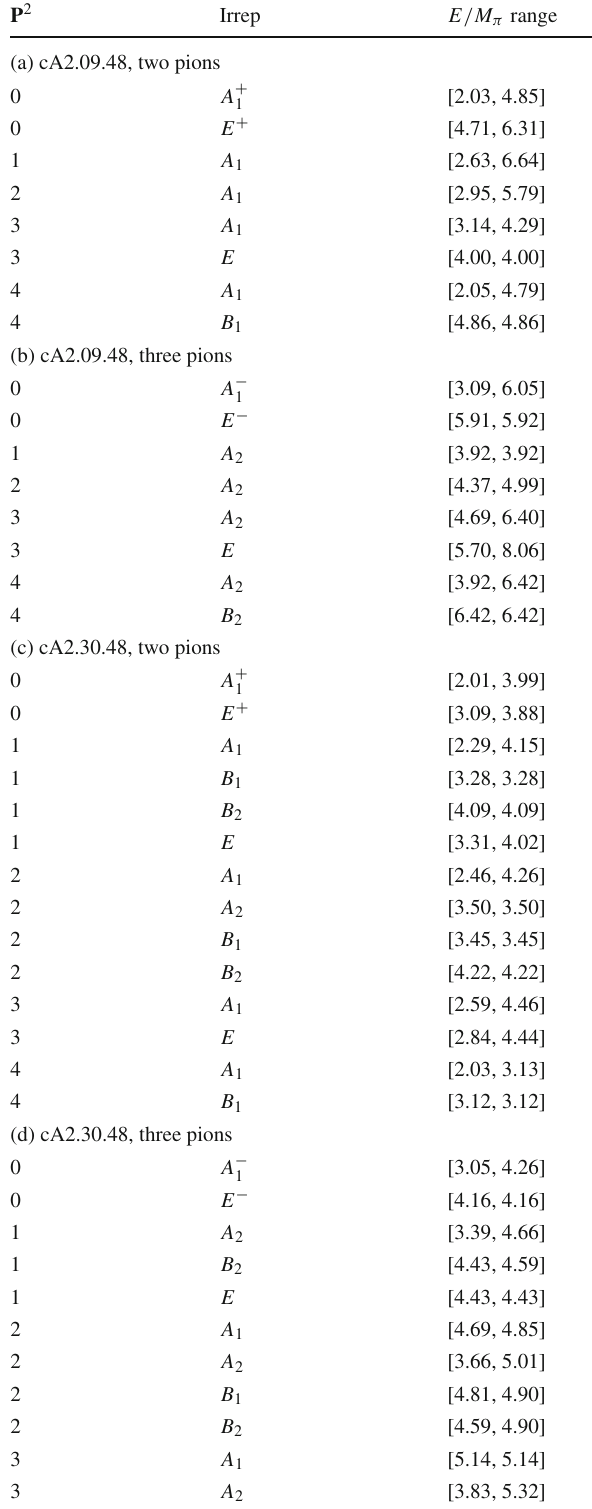
Table 9 Summary of energy levels included in this work. The E / M π rangeindicatesinwhichenergyrangetheenergylevelsfromthevarious principal correlators in that specific irrep where